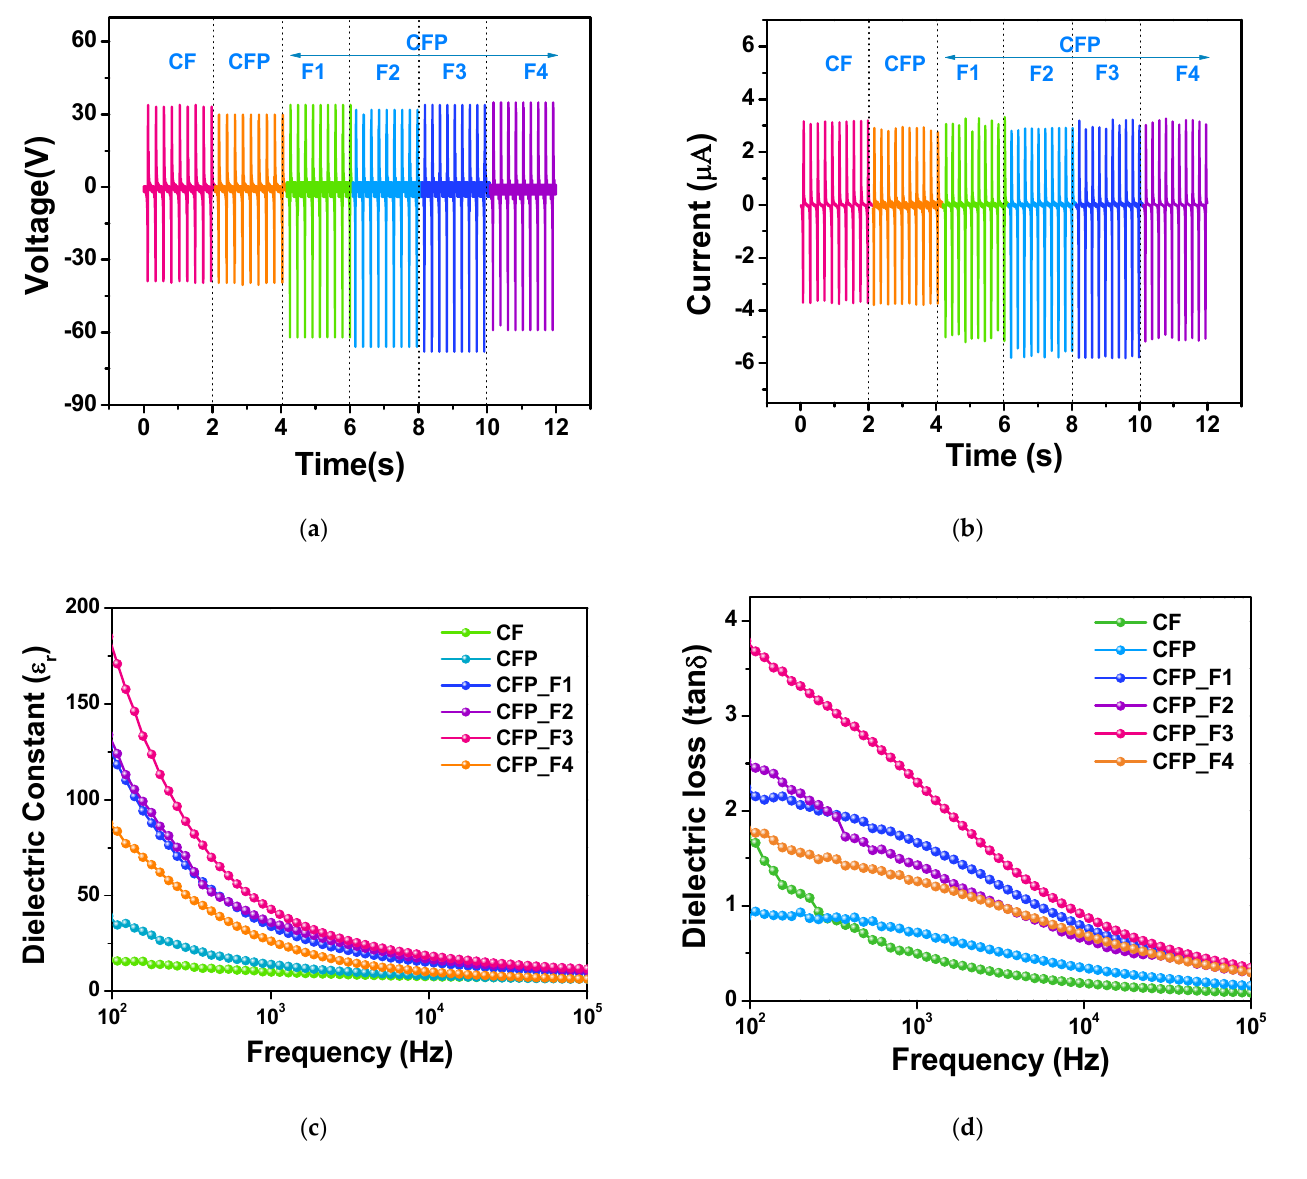
Figure 5. ( a ) Electrical output voltage and ( b ) current of the fabricated CF, CFP, CFP_F1 ‐ F4 TENGs under a single electrode mode at the applied impact force of 4N at 5 Hz. ( c ) Dielectric constant and ( d ) dielectric loss of CF, CFP, CFP_F1 ‐ F4 specimens. Table 3. Electrical output voltage ( V pp ) and current ( I pp ) of CF, CFP_F1–F4 TENGs. TENG